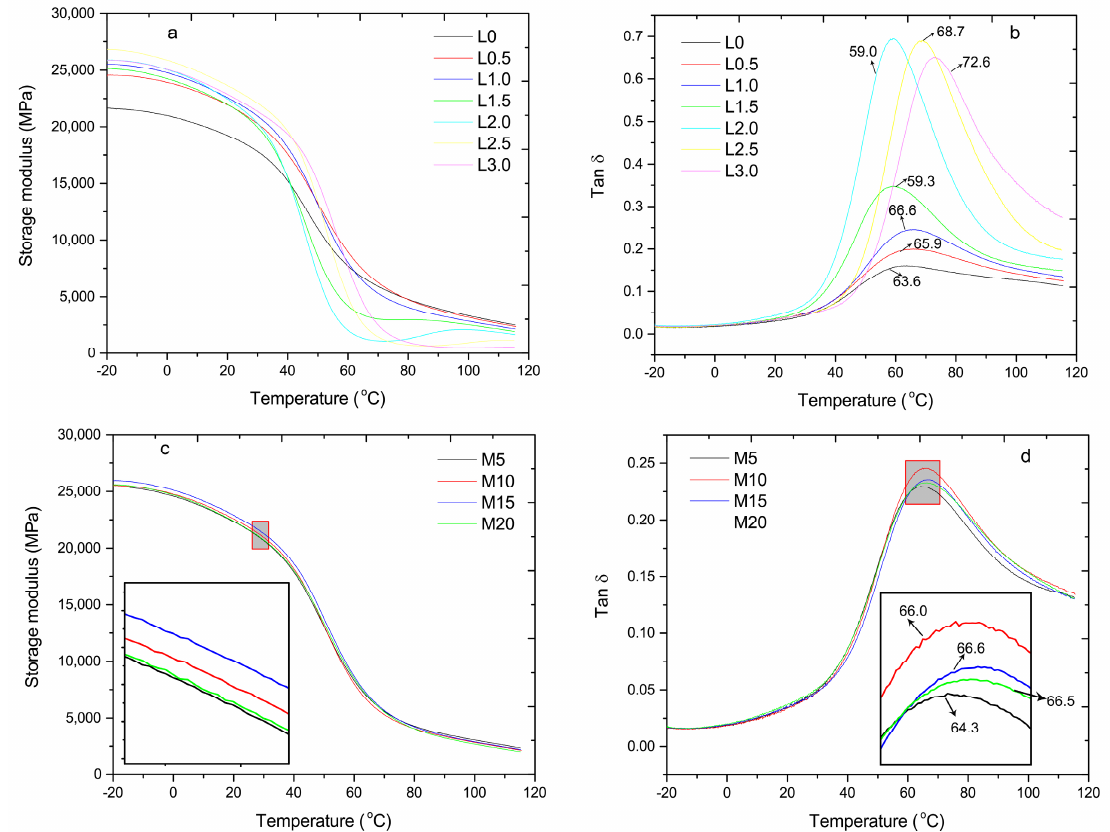
Figure 8. Dynamic mechanical properties for composites: ( a ) the storage modulus (E’) in various LiCl contents; ( b ) the loss factor (Tan δ ) in various LiCl contents; ( c ) the storage modulus in various MAPE contents; and ( d ) the loss factor in various MAPE contents.